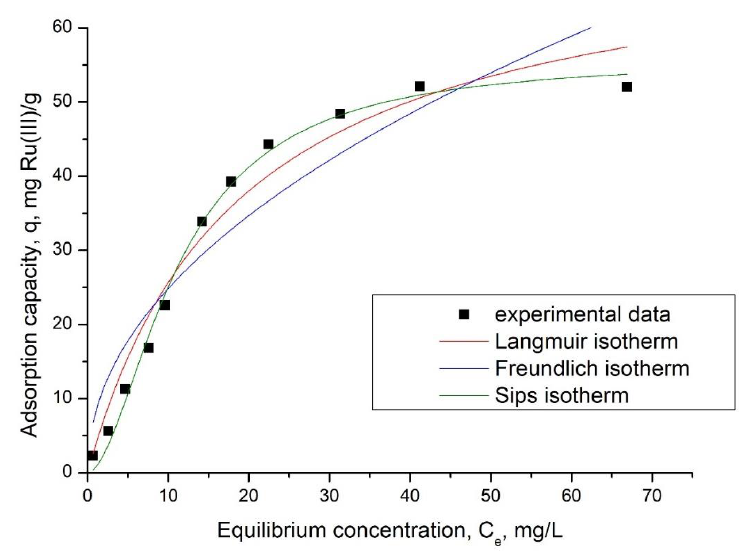
Figure 12. Adsorption isotherms.